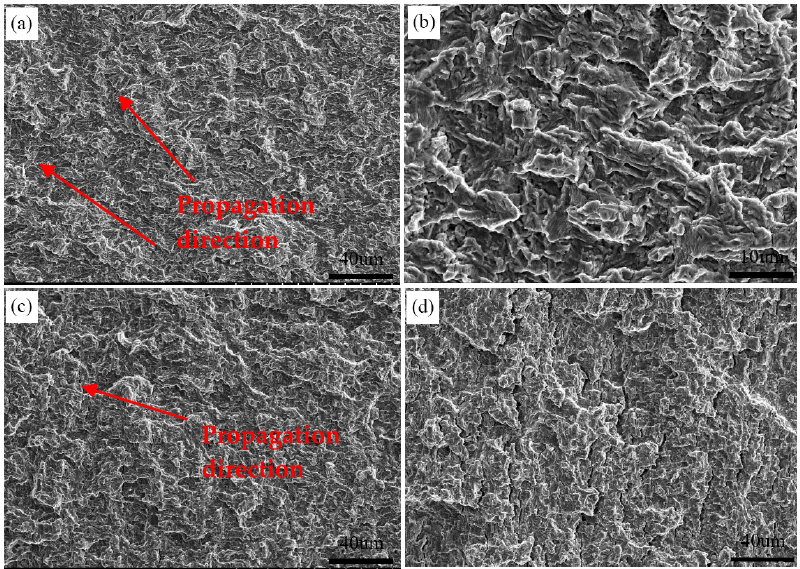
Figure 9. Typical SEM micrographs of fracture surface at peak temperature of 850 °C. ( a ) the fracture surface in the early stage; ( b ) magnified view in ( a ); ( c ) the area far away from the crack source; ( d ) the area close to ultimate fracture region.